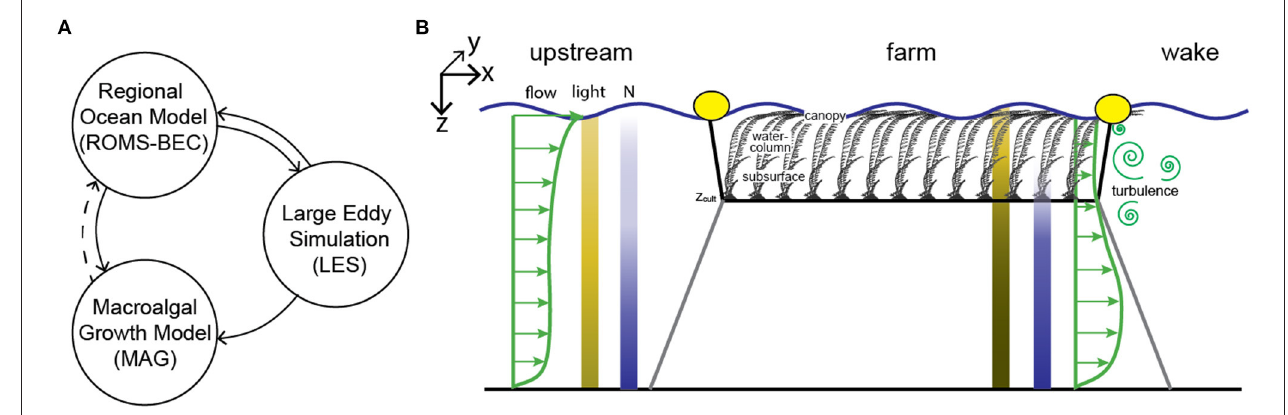
FIGURE 1 | (A) Relation among models used in this study. Solid lines represent flow of information in full-farm simulations. Dotted line represents additional pathway not included in current study. (B) Conceptual diagram illustrating the longline farm design for cultivation of Macrocystis pyrifera and anticipated farm-environment modifications. Coordinate system indicated. The along-farm perspective depicts a single longline with macroalgae cultivated at a depth of z cult . The presence of a suspended macroalgal farm modifies flow (both seawater velocity and turbulence), light, and nutrient conditions within and in the wake of the farm relative to upstream conditions. Longlines are aligned parallel to the x-dimension and repeated at a fixed distance (not shown; y-dimension). Macroalgae are cultivated along growth lines that extend in the y-dimension from the longline at a constant z cult